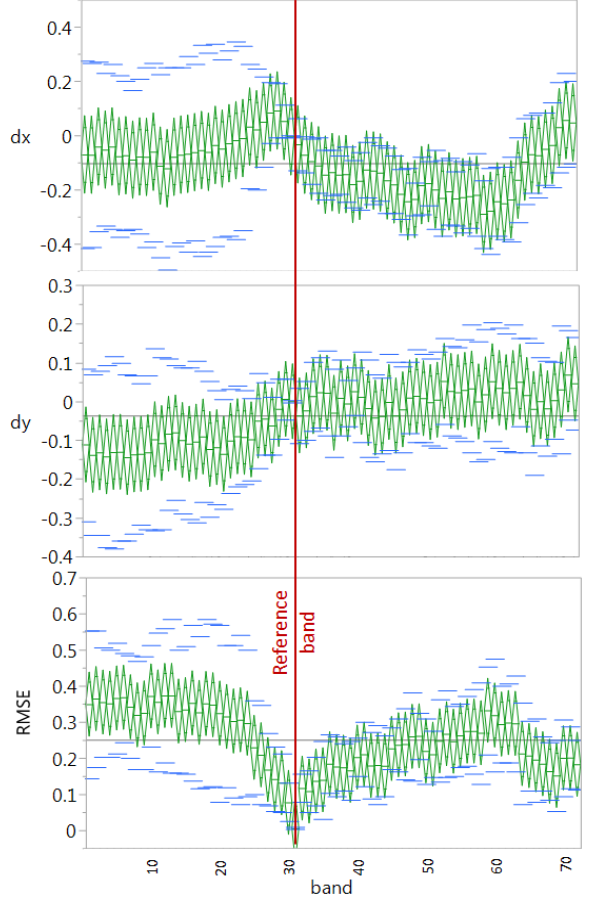
Figure 11. Average dx, dy and 2D RMSE (green, standard deviation marked in blue) for nine reference targets between respective spectral bands and the reference band 31.